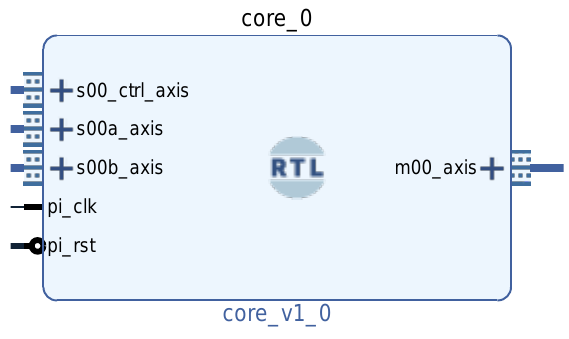
Figure 6. RTL block of MPA coprocessor in Xilinx Vivado